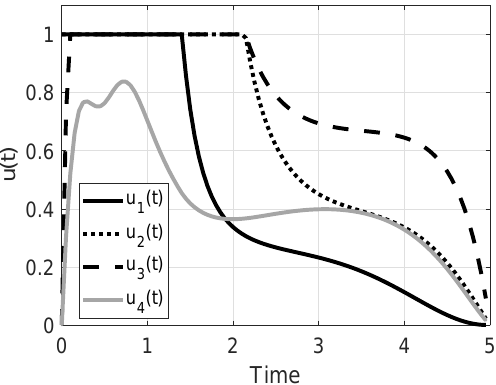
Figure 17. Case 5: evolution of the optimal control